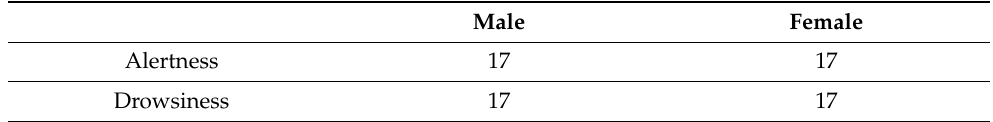
Table 1. The number of participants in each